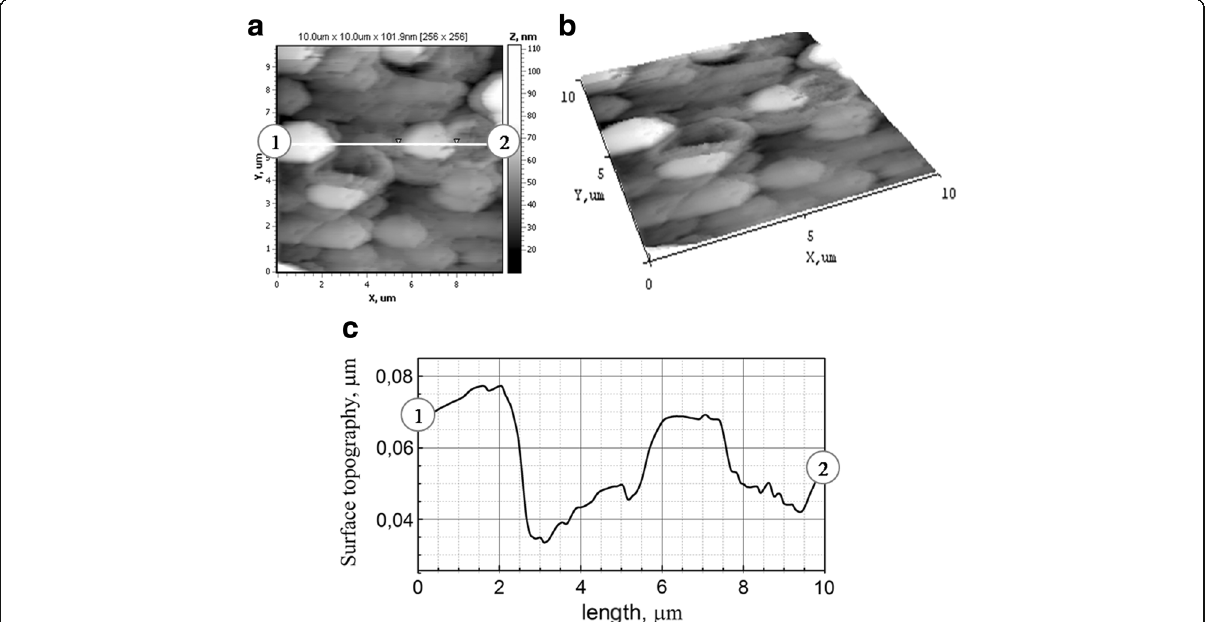
Fig. 7 a 2D and b 3D maps of the surface and c cross-sections between markers 1 and 2 for mild steel substrate. Scan area AFM 10.0 × 10.0 μ